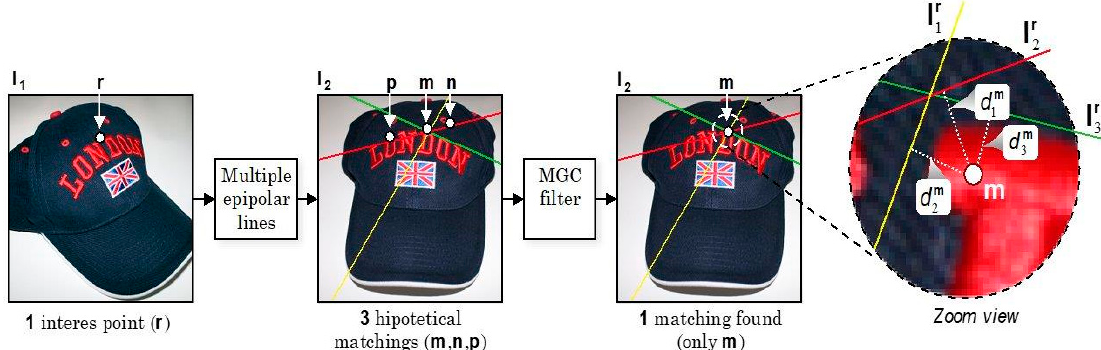
Figure 6. Point-correspondence and detection of wrong matches using the multiple geometric correspondence (MGC) filter.